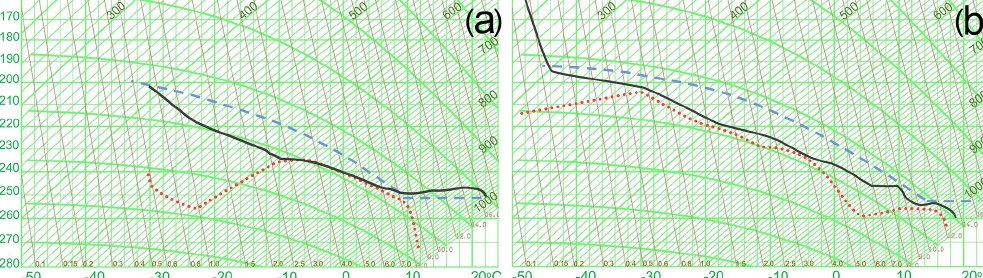
Figure 11. Vertical profiles for (a) Tzafit (26 April 2018 at 09:30UTC) and (b) Beit Shean (26 April 2018 at 12:30UTC). The black lines denote temperature, the dotted red lines dew point and the dashed blue lines the adiabatic cooling of air parcels ascending from the